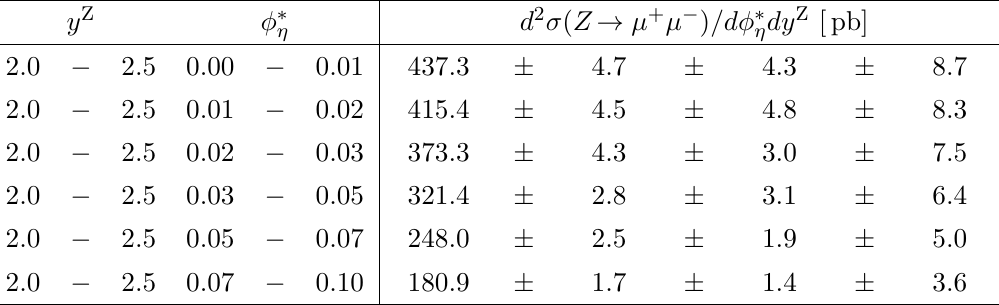
Table 17. Measured double differential cross-sections in interval regions of y Z and p Z uncertainty is statistical, the second systematic, and the third is due to the